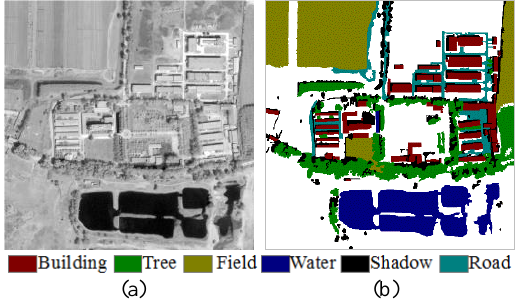
Figure 4 (a) The original panchromatic QuickBird image, (b) The ground truth map